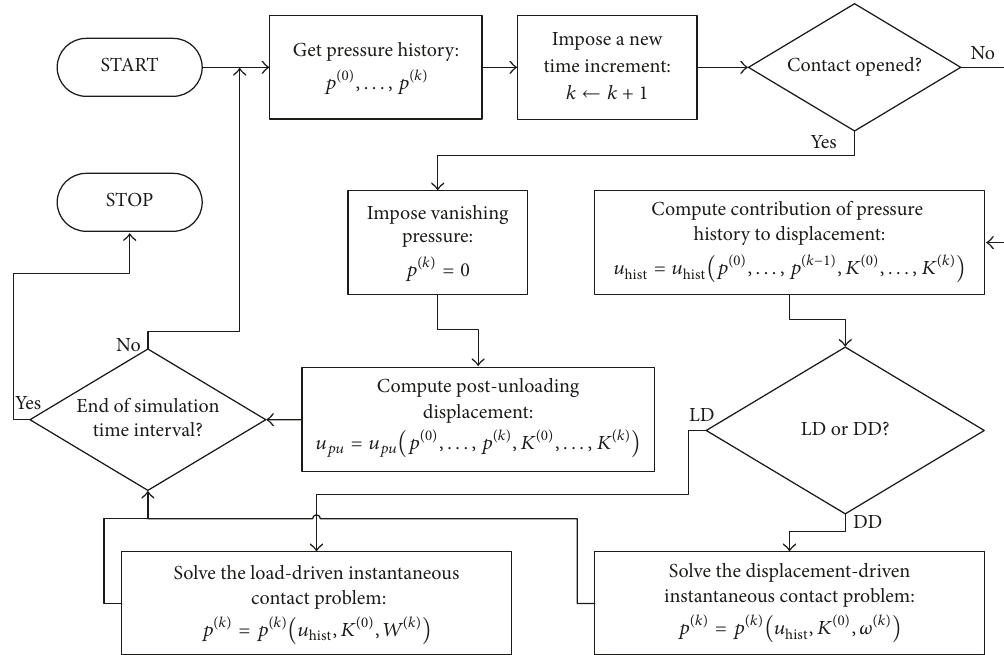
Figure 3: Algorithm flowchart for the transient viscoelastic